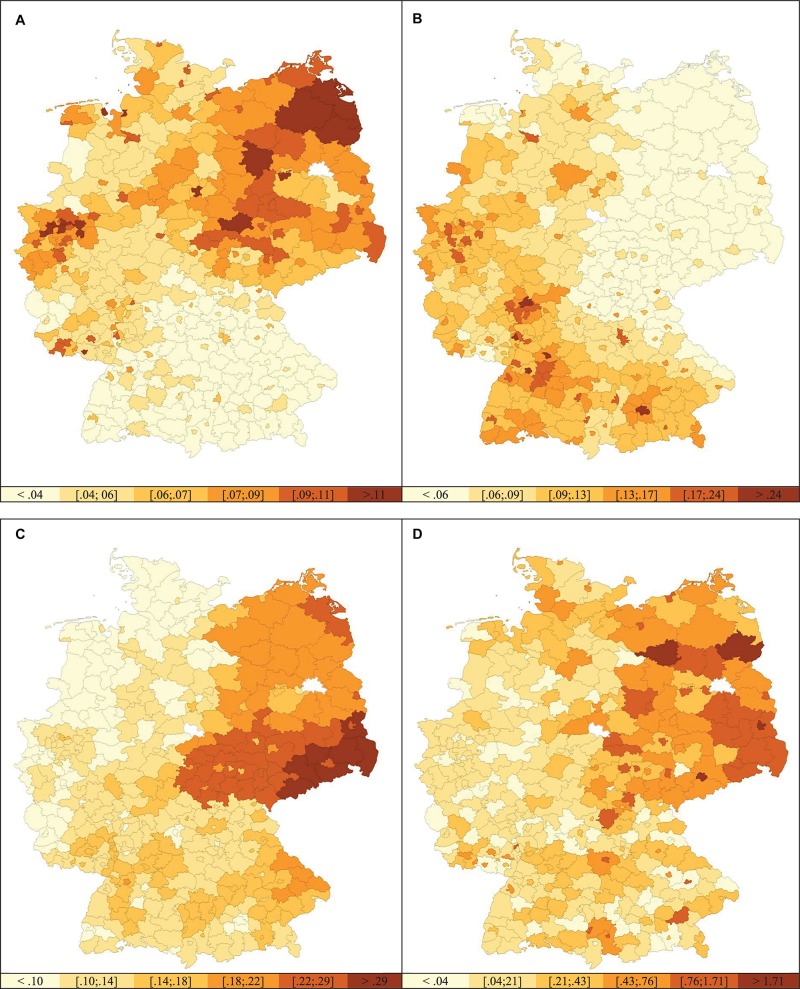
Natural breaks maps of Germany illustrating spatial distributions of socio-structural and outcome variables: (A) unemployment rate, (B) proportion of foreigners, (C) far right electoral support, (D) and right-wing crime. Berlin was excluded from the analyses.